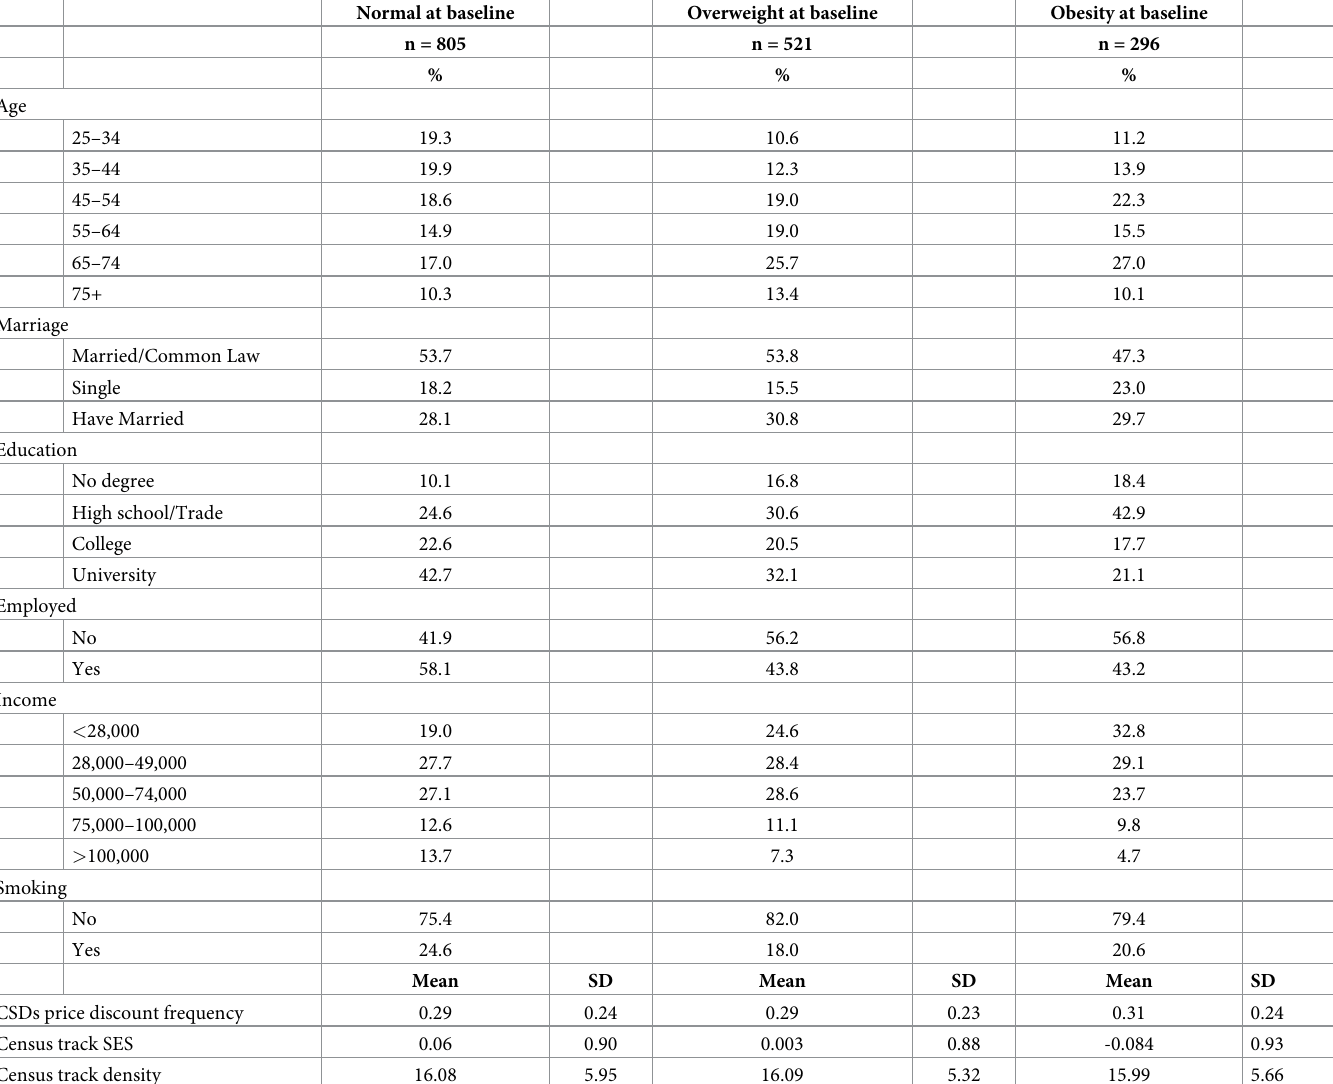
Table 1. Characteristics of female participants in the Montreal Neighborhood Networks and Healthy Aging (MoNNET-HA) in 2008 (at the baseline, n = 1,622; the prevalence of obesity: 18.3% in 2008, 19.9% in 2010 and 20.7% in 2013). Normal at